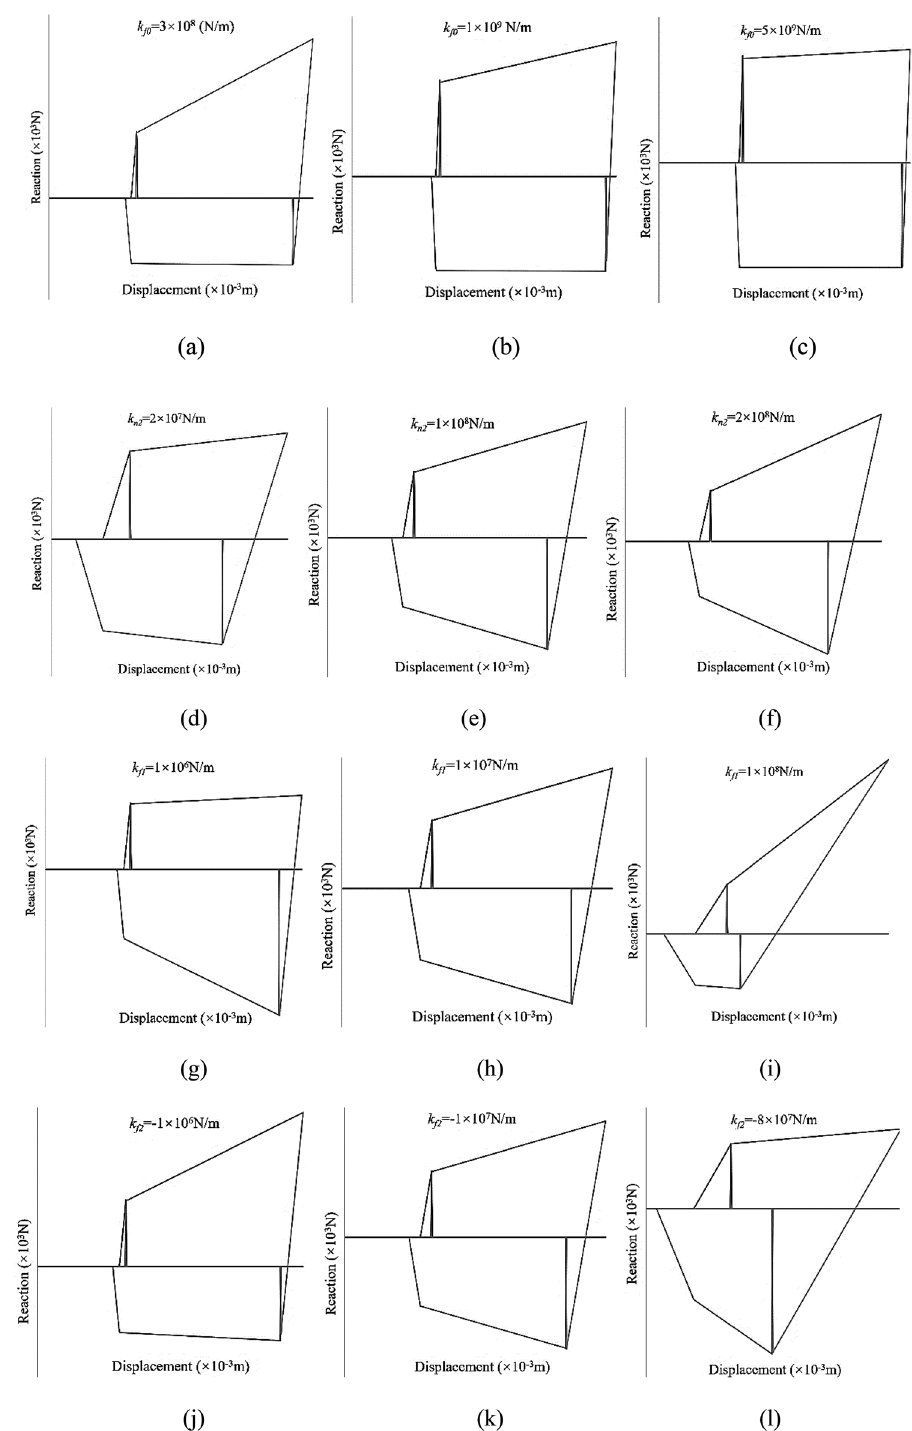
Fig. 11 Geometric shift that one optimization variable monotonically